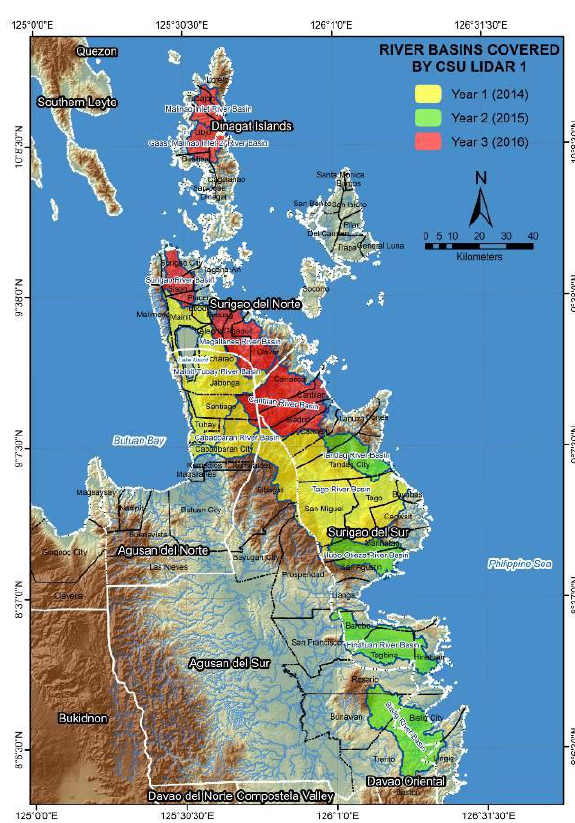
Figure 1. The twelve river basins in Caraga Region, Mindanao, Philippines covered by the Flood EViDEns